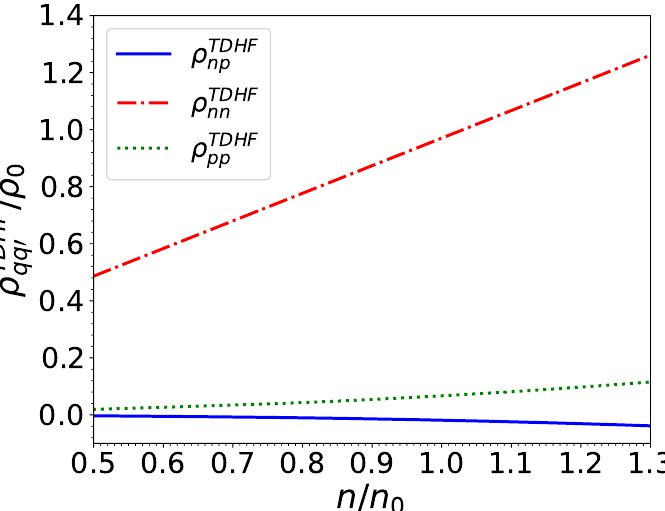
Figure 11. Entrainment matrix elements (normalized by the saturation density ρ 0 = n 0 m ) for npe µ matter in beta-equilibrium at zero temperature and in the limit of small currents at baryon densities prevailing in neutron-star cores in units of the saturation density n 0